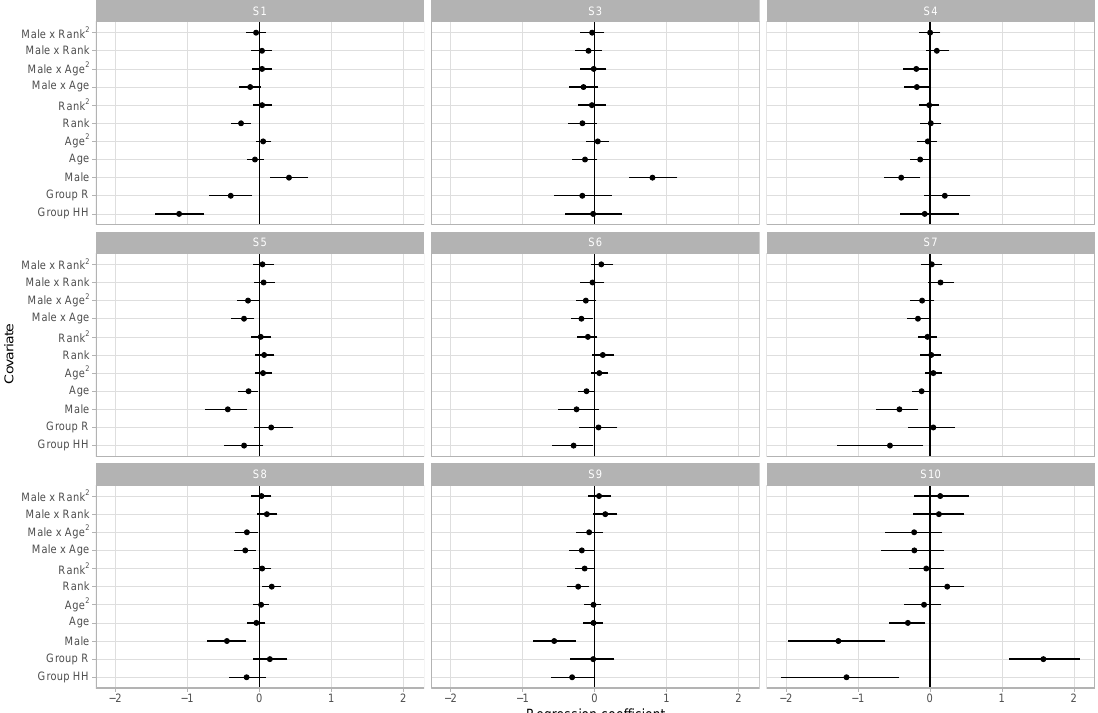
Figure 4. Regression coefficients with S2 as a baseline (see Methods). Points represent posterior means and lines, 95% central credible